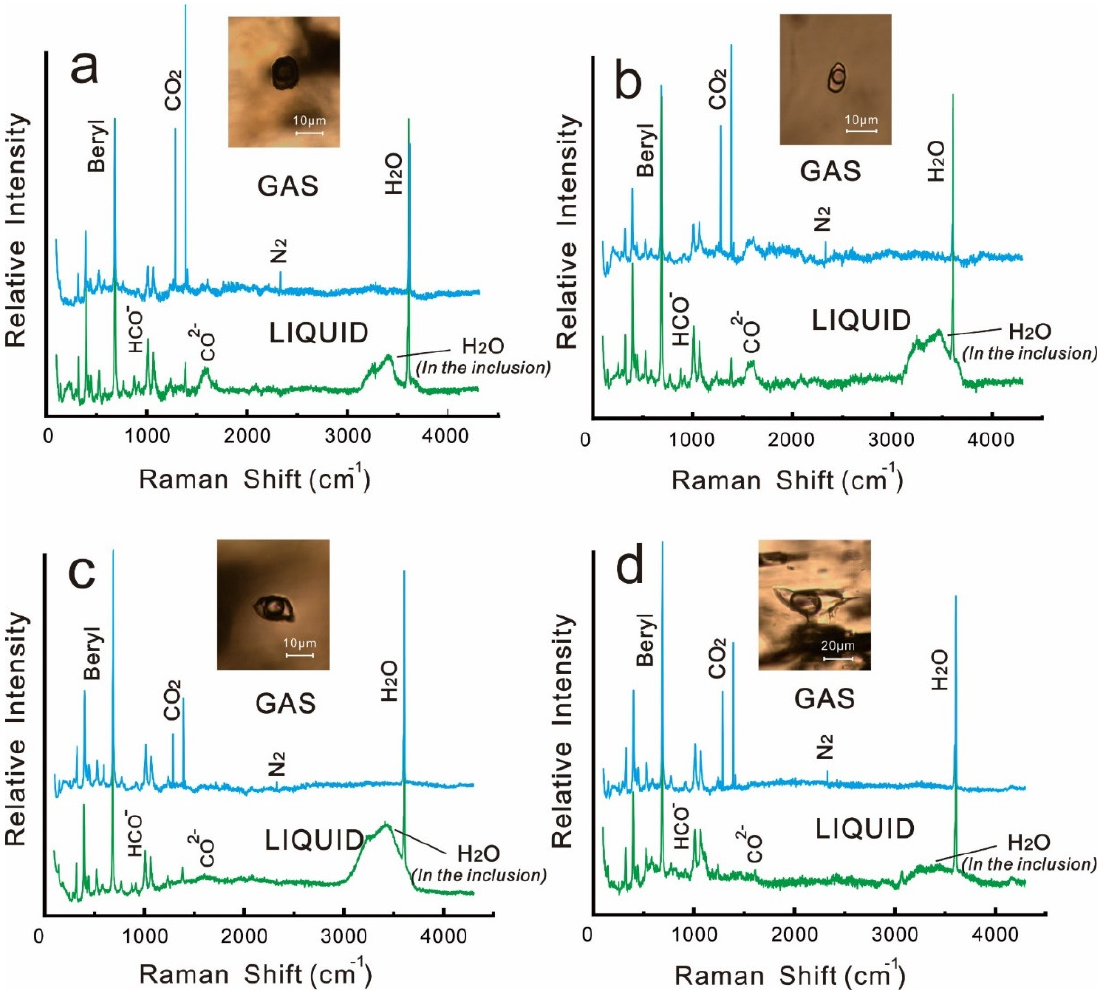
Figure 8. ( a – d ) Four typical isolated fluid inclusions were tested by Raman spectrum, ranging in size from 10 μm to 40 μm. The results are shown on the right. Raman spectra of gas and liquid are shown in blue and green, respectively.